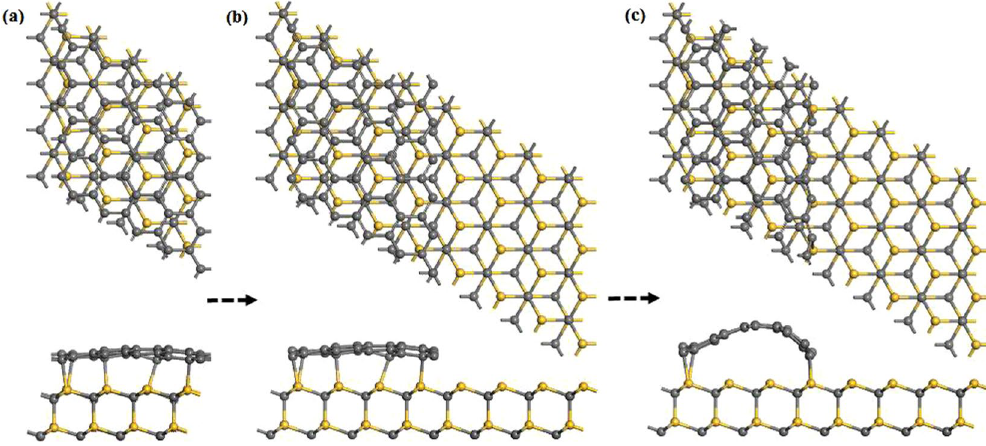
Figure 1. ( a ) Atomic structure of a (5 × 5) graphene placed on the (4 × 4) SiC (0001) surface. ( b ) and ( c ) Are the structures of graphene with zigzag edge on SiC substrate before and after relaxation, respectively.